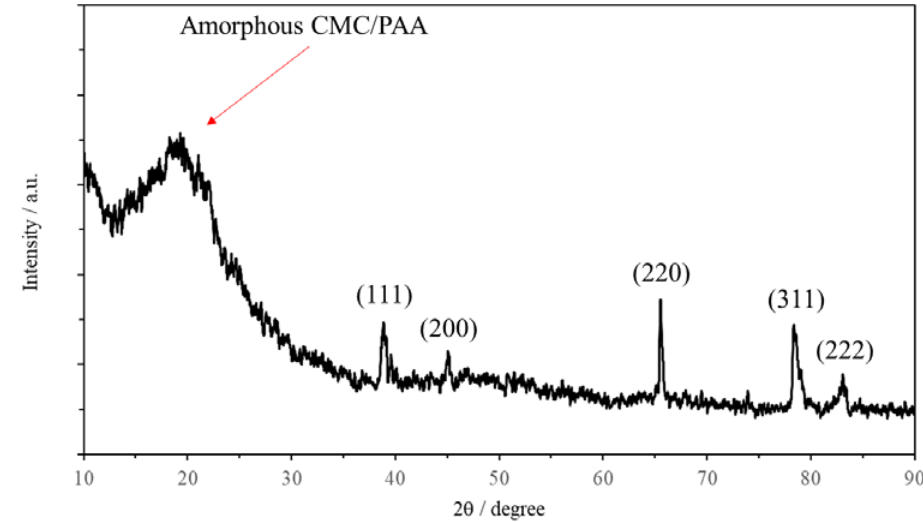
Figure 2. X-ray pattern for aluminum-based Figure 2. X - ray pattern for aluminum - based aerogel.